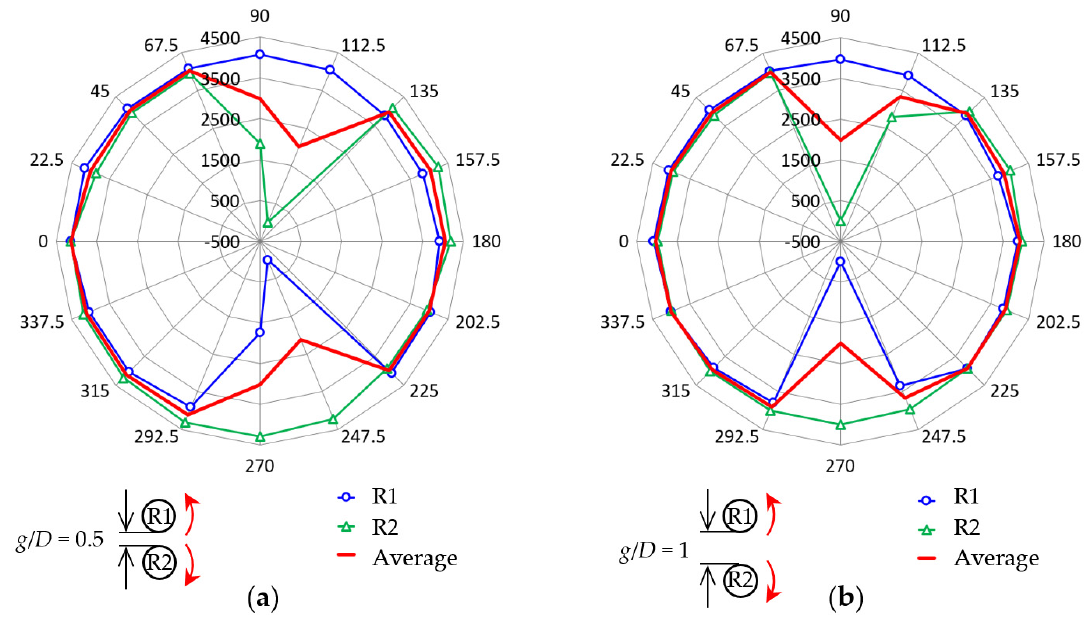
Figure 14. IR configuration of 16-wind-direction dependence on two VAWTs at V = 14 m/s: Figure 14 . IR configuration of 16 ‐ wind ‐ direction dependence on two VAWTs at V = 14 m/s: ( a ) g / D ( a ) g / D = 0.5; ( b ) g / D = = 0.5; ( b ) g / D = 1.